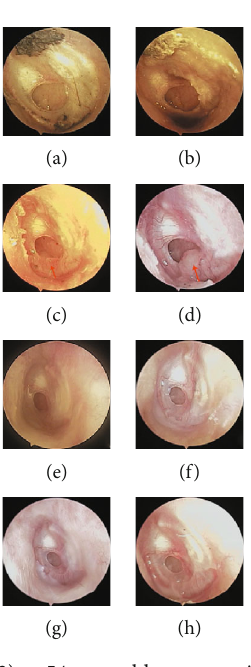
Figure 2: (Patient 2): a 54-year-old woman with COM and a left medium-sized perforation. Pretreatment perforation (a) and the perforation after 2 (b), 6 (c), 8 (d), 12 (e), 18 (f), 19 (g), and 23 (h) weeks of treatment. Red arrows indicate moderate granulation reaction.